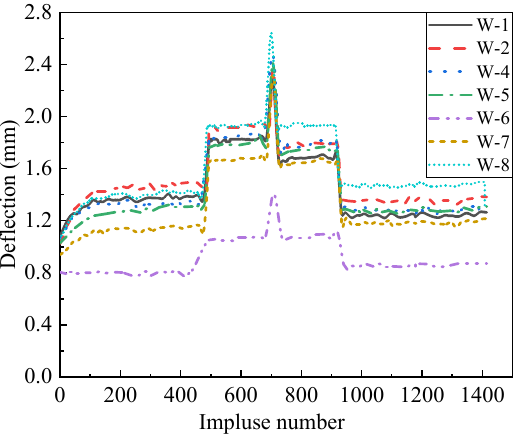
Figure 10. Deflection histories of all measurement points.